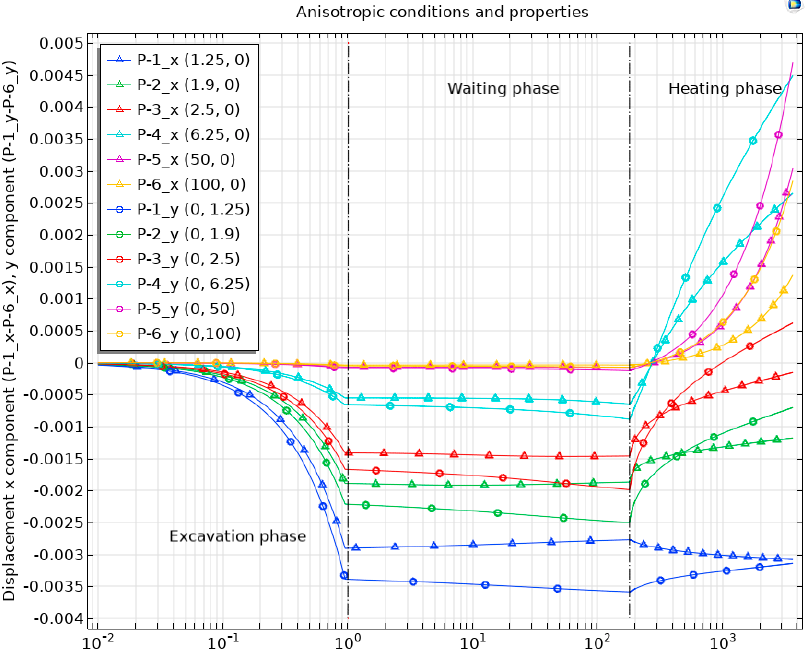
Figure 16. UDC variant: evolution of displacements (x component) at selected under the anisotropic stress conditions and anisotropic properties.